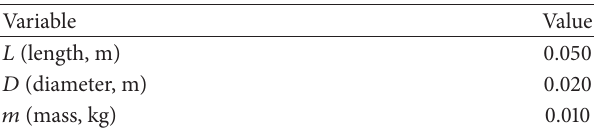
Figure 8: Perspective view of the 3D solid model of the actuator. Table 3: Actuator dimensions and